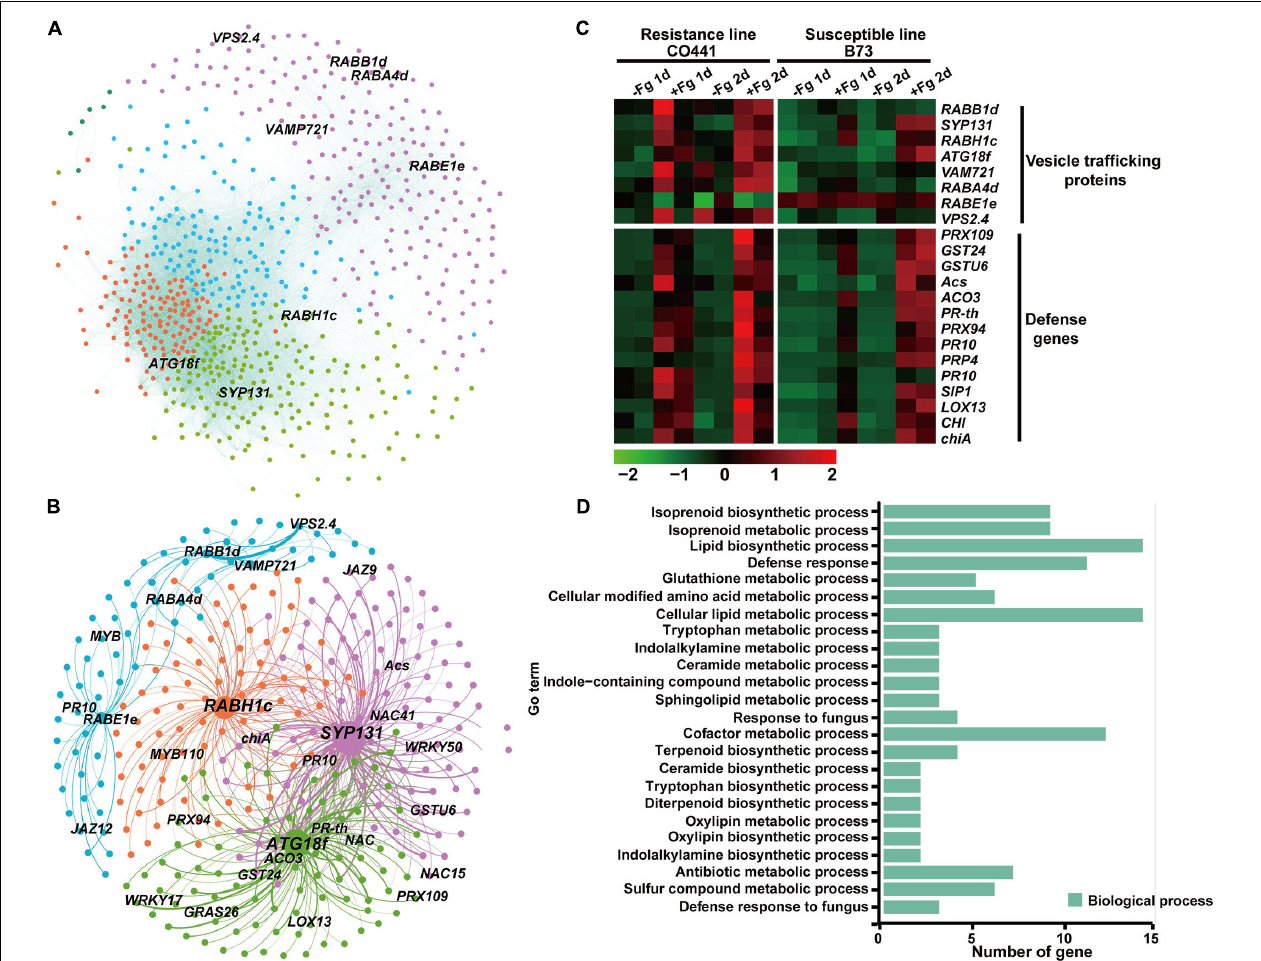
FIGURE 4 | Co-expression of membrane-trafficking genes responding to Gibberella ear rot disease in two maize inbred lines. (A) Co-expression network of module red. Nodes are color coded based on the consensus modules identified using the R language WGCNA package. Edges are constructed between genes with a correlation coefficient ( r ) > 0.15. (B) The subnetwork with membrane-trafficking genes for visualization in module red. (C) Expression profiles of defense and membrane-trafficking genes in module red upon Gibberella infection. The values in red and green indicate gene increases and decreases in expression, respectively. (D) Gene ontology (GO) enrichment analysis of co-expressed genes of module